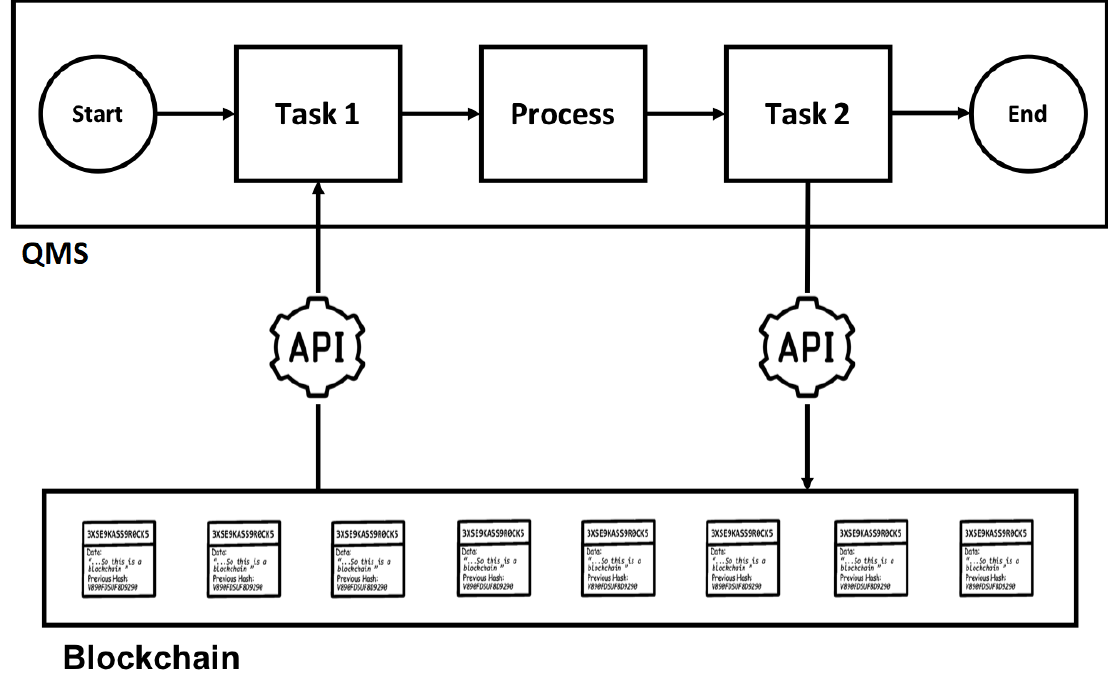
Figure 2: Communication between the QMS and